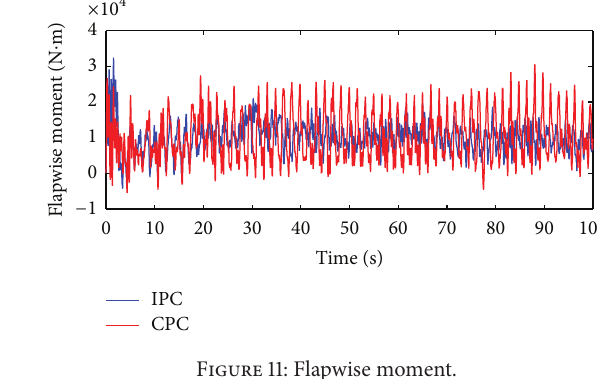
Figure 8: Tower fore-aft bending moment.